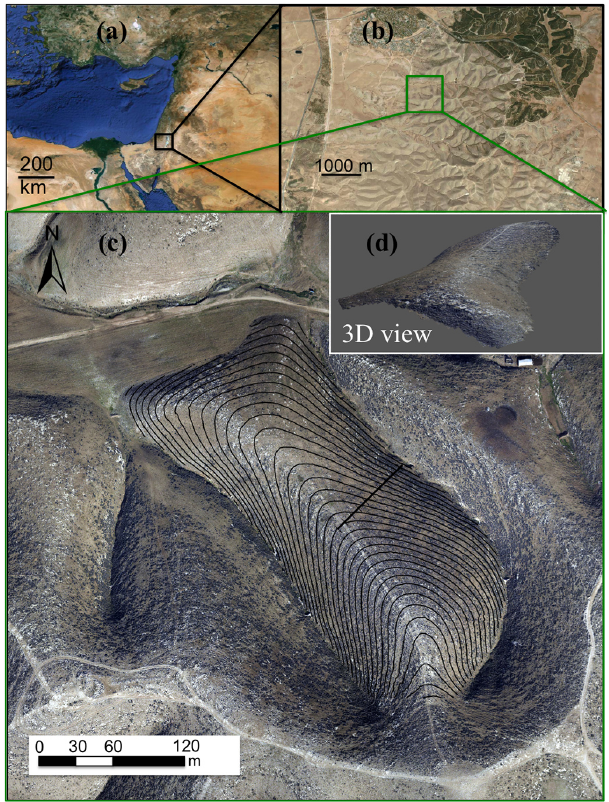
Figure 1. The study region and site. The Long Term Ecological Re- search (LTER) site, in southern Israel, is uniquely situated at a mar- gin between Mediterranean climatic regime to the north and arid climate to the south (a) . The study site is located on a loess belt (b) deposited during the late Pleistocene and early Holocene. Hill- slopes in this region are today mostly depleted of their loess cover ( c , d ). The contour lines in (c) are at 2m intervals.